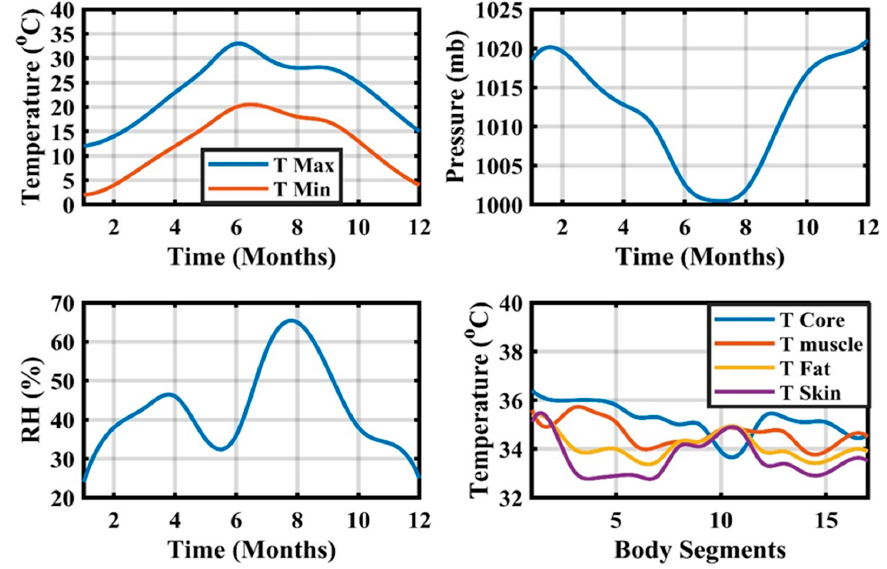
Figure 6. Environmental data analysis.